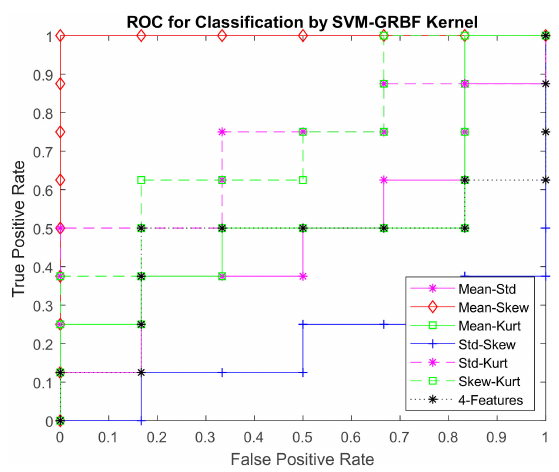
Figure 20. ROC curve for 2D-features classification by SVM-GRBF with C = 500, and Sigma = 1.658.